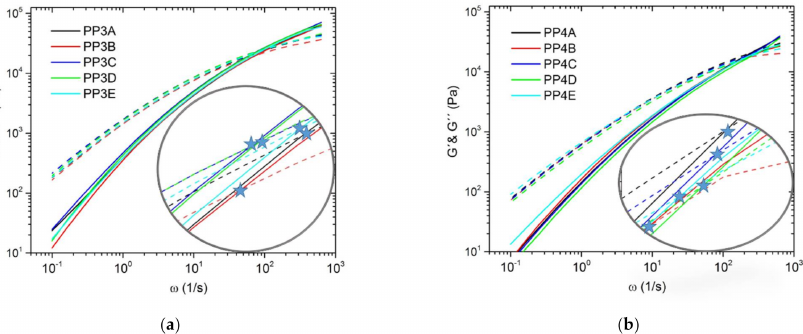
Figure 4. Storage modulus ( G (cid:48) ) lines and loss modulus ( G ”) dashed lines of the series PP3 ( a ) and PP4 ( b ) and their blends; the stars represent the crossover point of the two curves ( G (cid:48) and G ”) of the respective blend series; measured at 230 ◦ C.